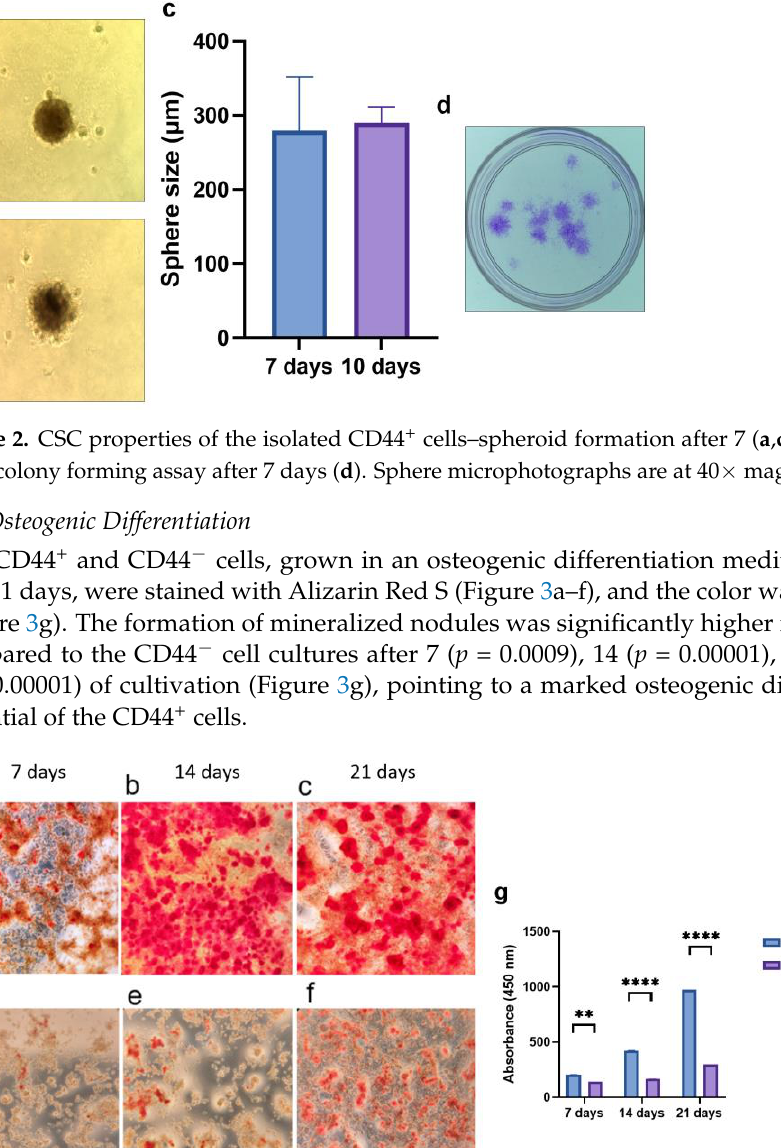
Figure 1. Cell cultures. Primary tumor cells arising from tumor tissue are indicated by an asterisk ( a ) and CD44-positive ( b ) and CD44-negative ( c ) cells after magnetic-activated cell sorting. All microphotographs are at 40× magnification.